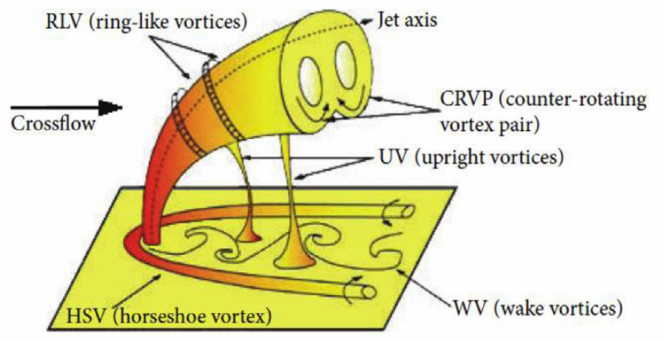
Figure 5. Vortical structures in a jet in cross-flow (JICF) [76].